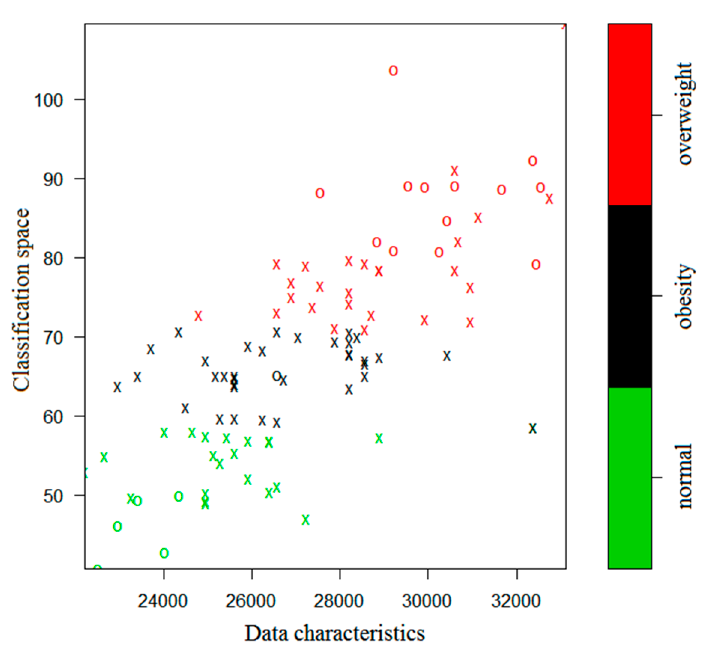
Figure 4. Classification for the 250 KHz case by the iSVM.